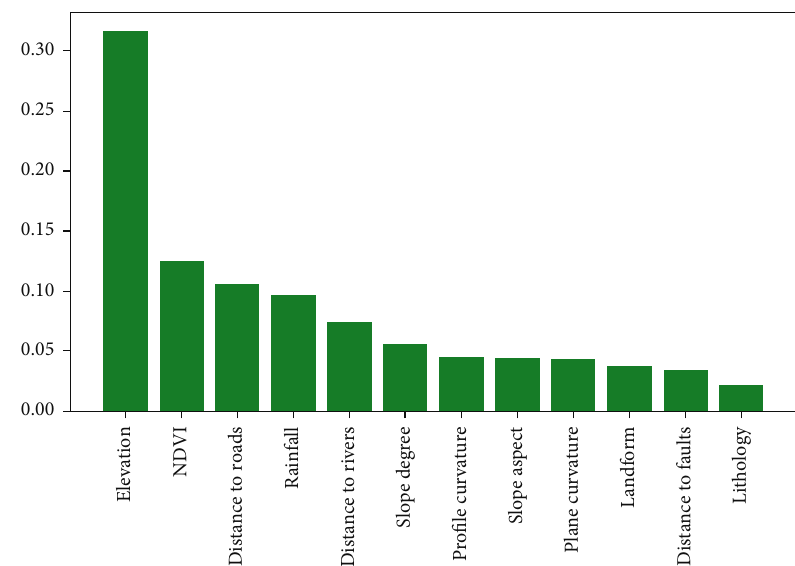
Figure 10: Distribution of factors with GA-RF